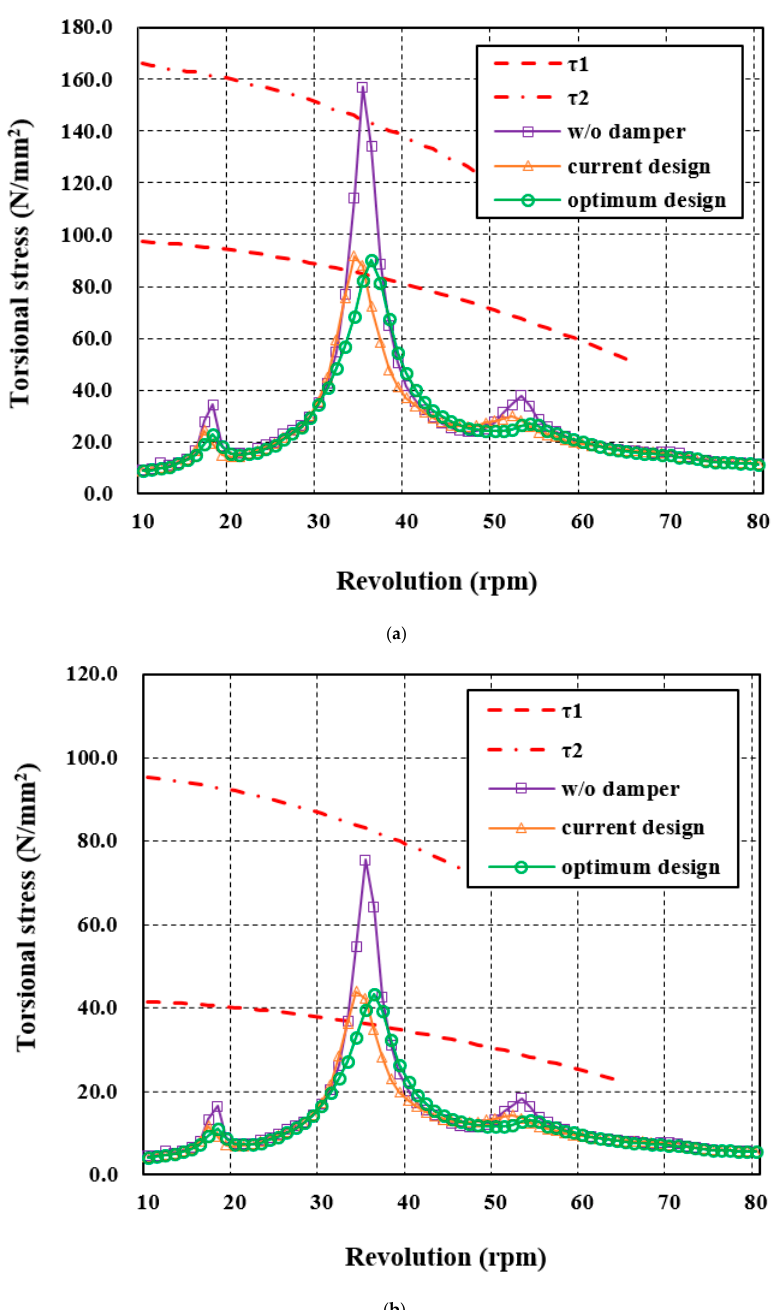
Figure 6. ( a ) Synthesized torsional stress of the intermediate shaft. ( b ) Synthesized torsional stress of the propeller shaft.